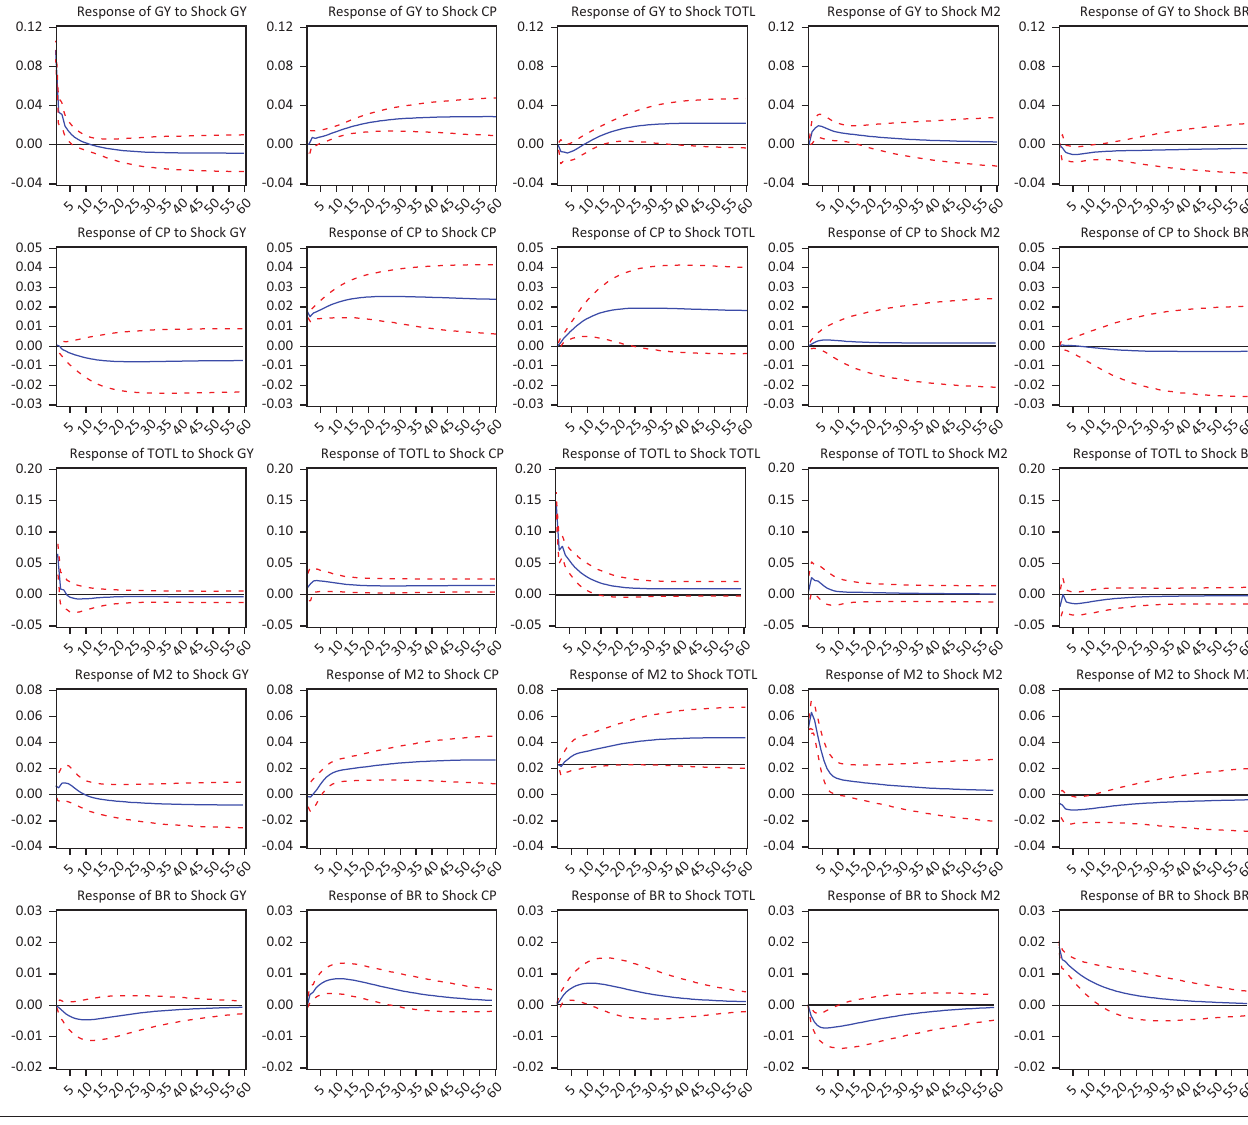
FIGURE 4-A1: Impulse responses with aggregated formal financial sector and informal financial sector